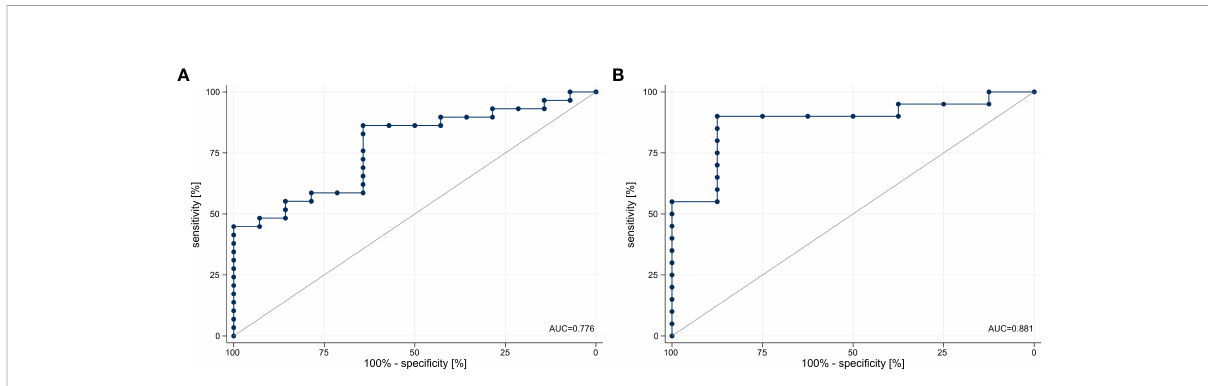
FIGURE 2 ROC curves for response prediction of Scores A and B (A) ROC curve was drawn for response prediction of Score A (AUC = 0.776, 95% CI 0.633 – 0.919). (B) ROC curve was drawn for response prediction of Score B (AUC = 0.881, 95% CI 0.743 – 1.000). ROC, receiver operating characteristic, Score A = Tregs ÷ (CD4 + /CD8 + ratio), Score B = Tregs × HLA-DR + CD4 + T cells × PD1 + CD8 + T cells, AUC, area under the